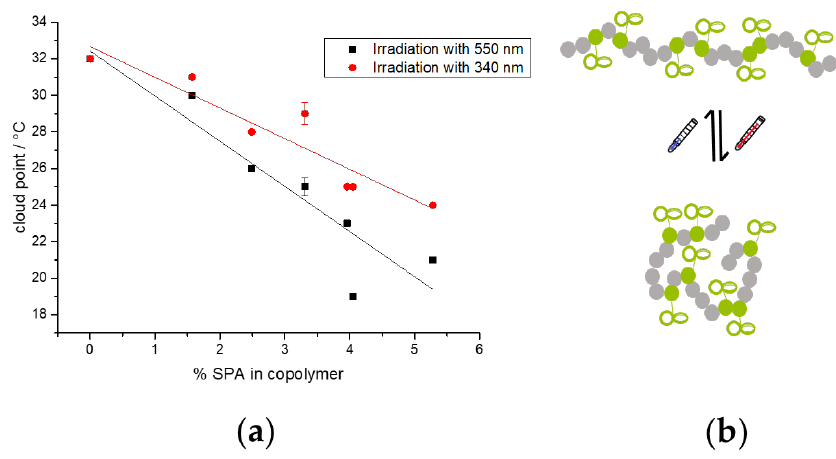
Figure 5. ( a ) Determined transition temperatures between the soluble SP and insoluble MC forms for copolymers containing different amounts of SPA; the red and black lines are just a guide to the eye; ( b ) Schematic view on the transition of the copolymer between soluble and insoluble upon temperature